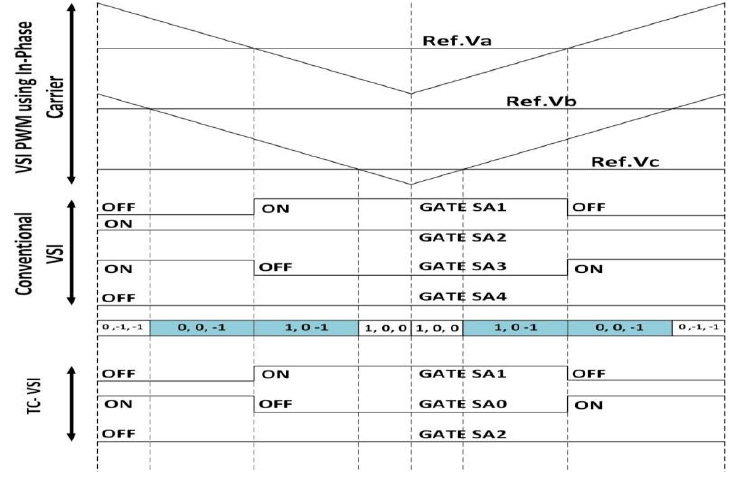
Figure 6. PWM technique description.